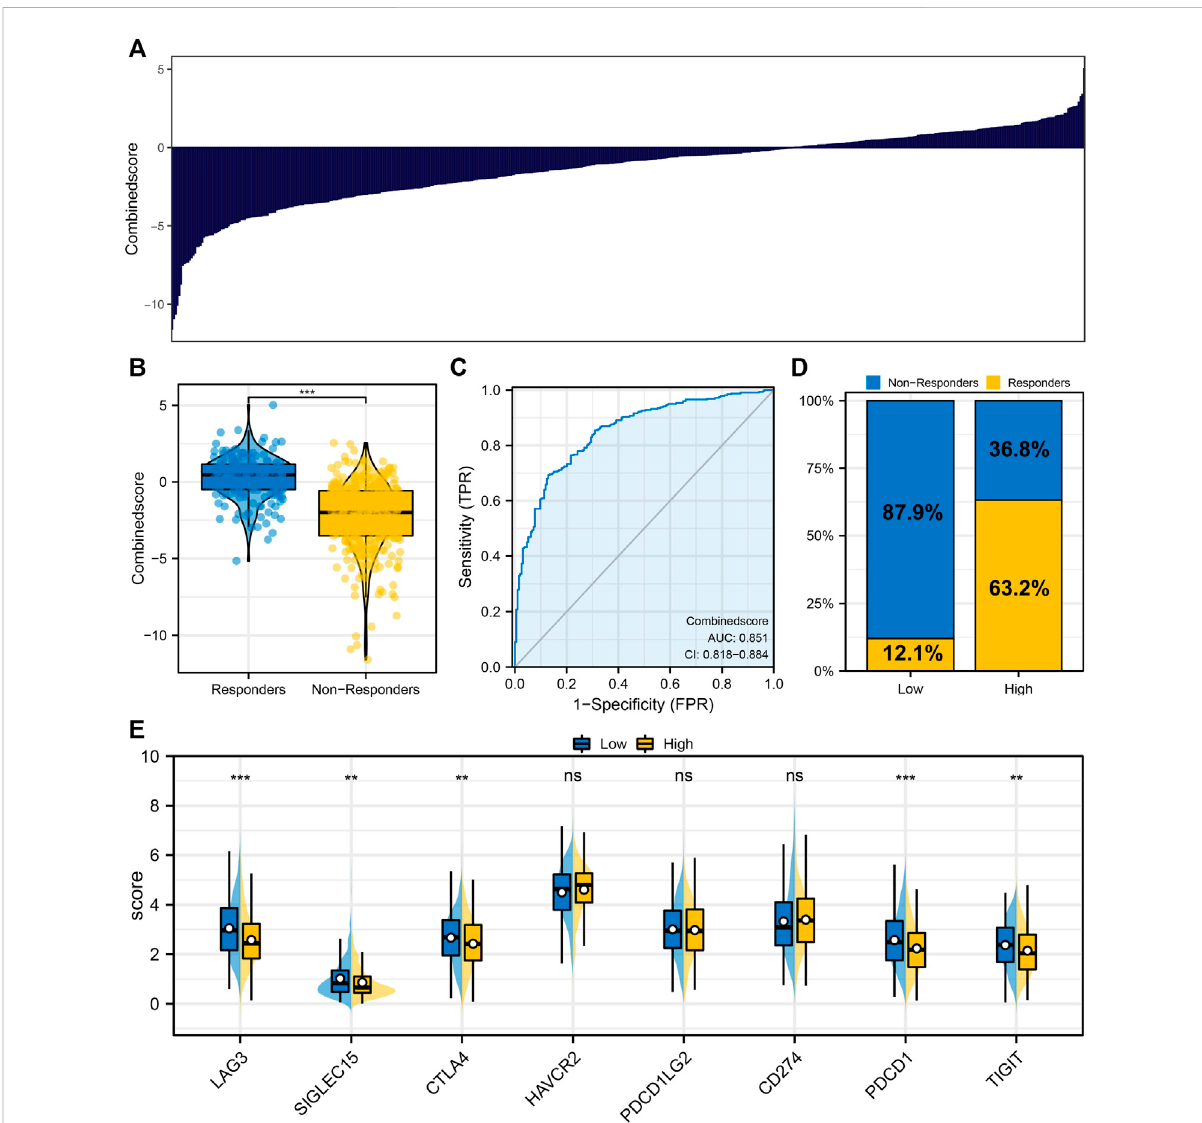
FIGURE 3 Logistics regression model. Notes: (A) Logistic regression model was constructed based on the identi fi ed characteristic genes; (B) Differences oflogistics score betweenimmunotherapy responders and nonresponders; (C) ROC curvewas utilized to assess theperformance of Logistics score in predicting the response to immunotherapy in LUAD patients; (D) Proportion of immunotherapy responders and non-responders in patients with high and low logistics score; (E) The level of key immune checkpoints in patients with high and low logistics